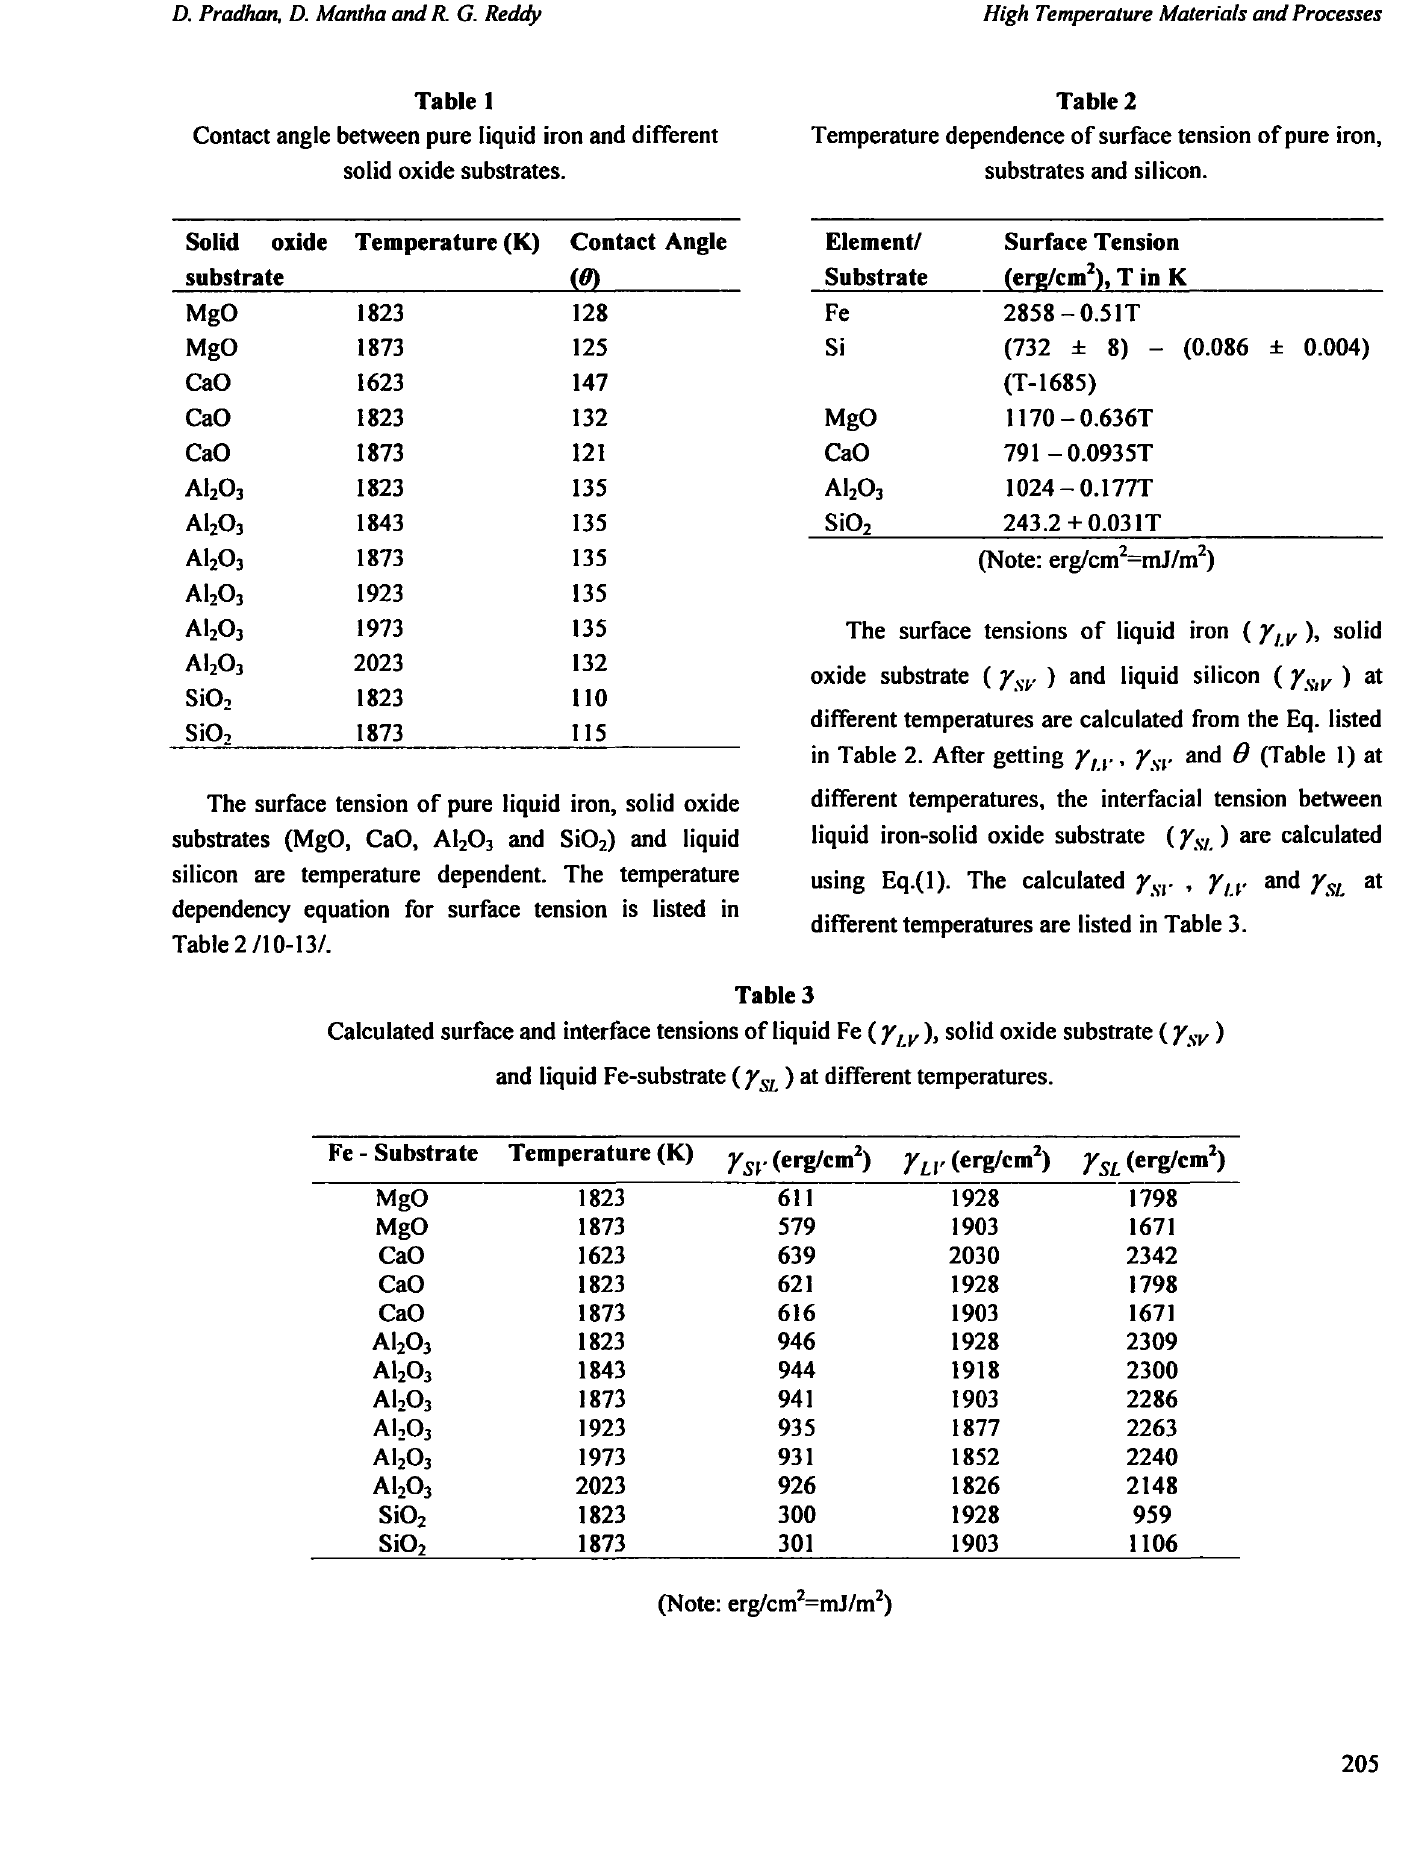
Contact angle between pure liquid iron and different solid oxide substrates.